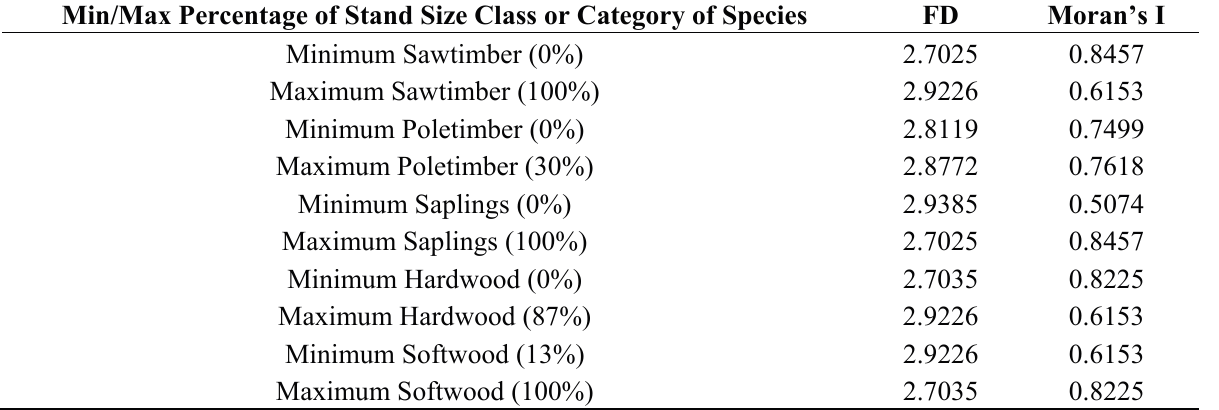
Table 3. FD and Moran’s I values at the minimum and maximum percentages of each stand size class and category of species among all study